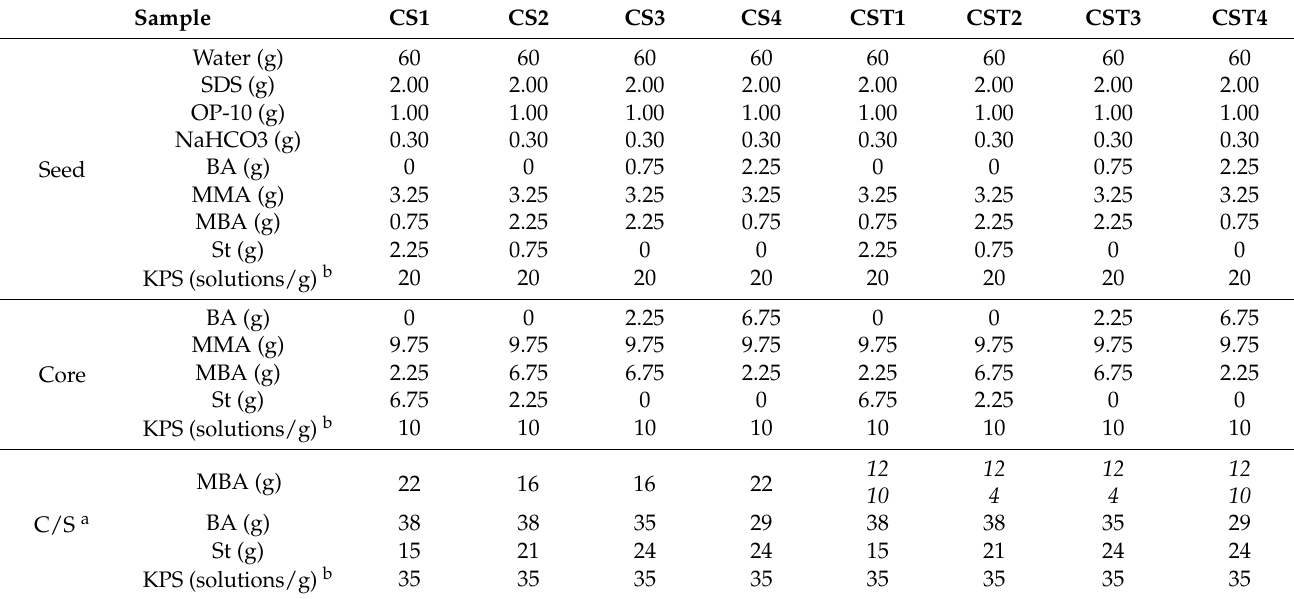
Table 2. The recipes used for the synthesis of core/shell